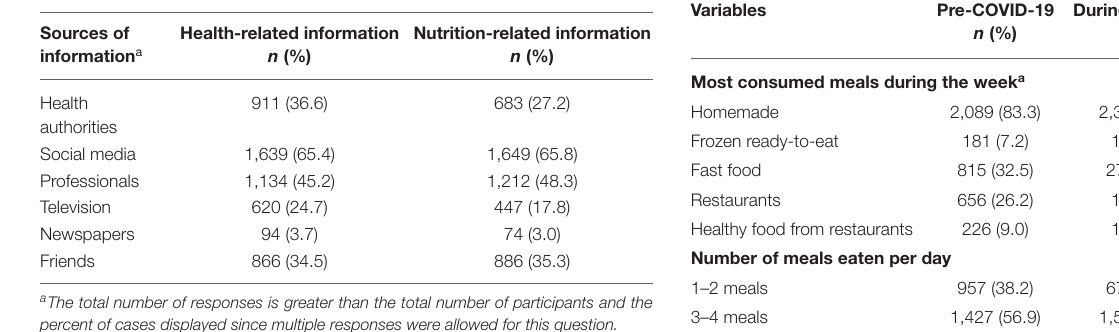
TABLE 2 | Sources of health and nutrition information during COVID-19 pandemic ( n = 2,507). Sources of information a